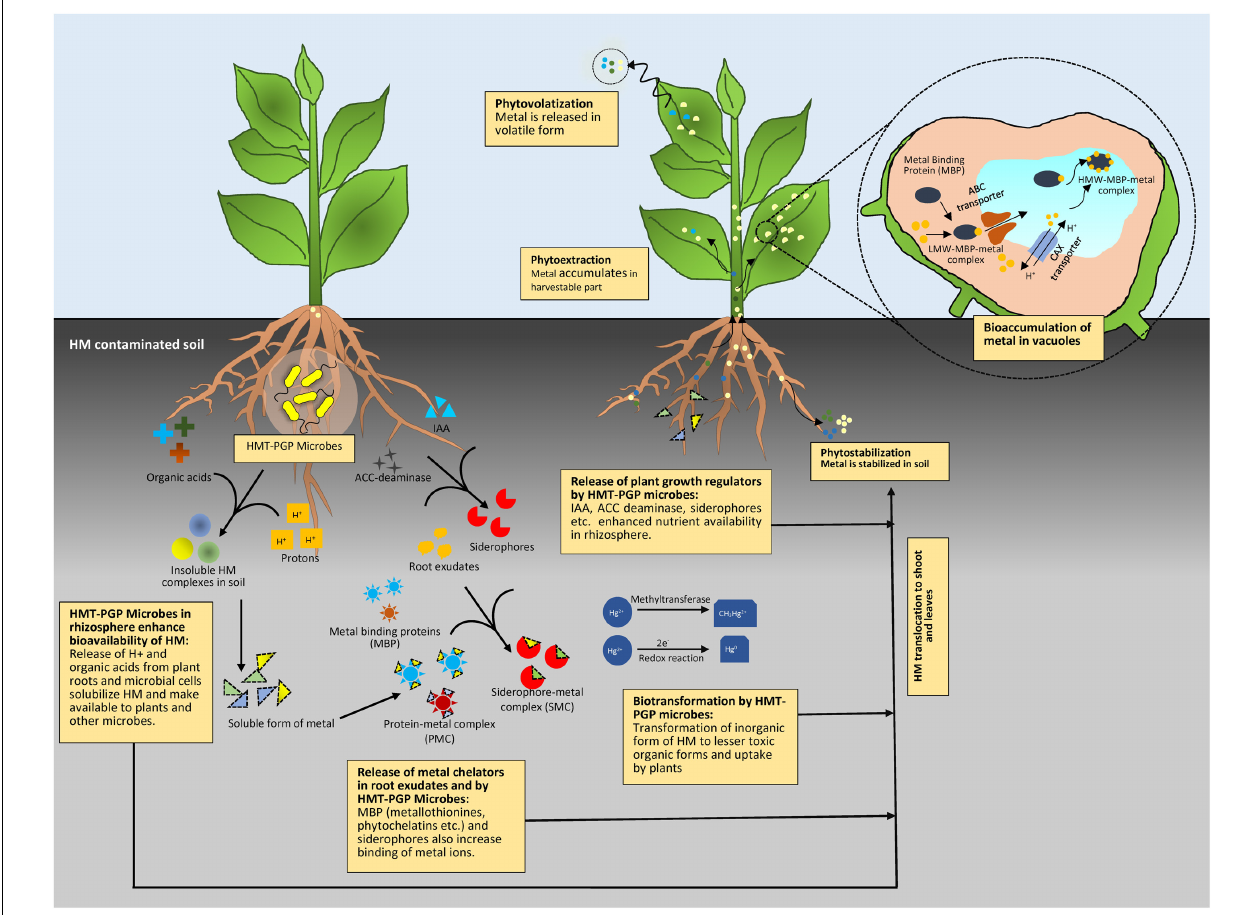
FIGURE 1 | Mechanisms involved in remediation of HM contaminated soil by HMT-PGP microbes–plant